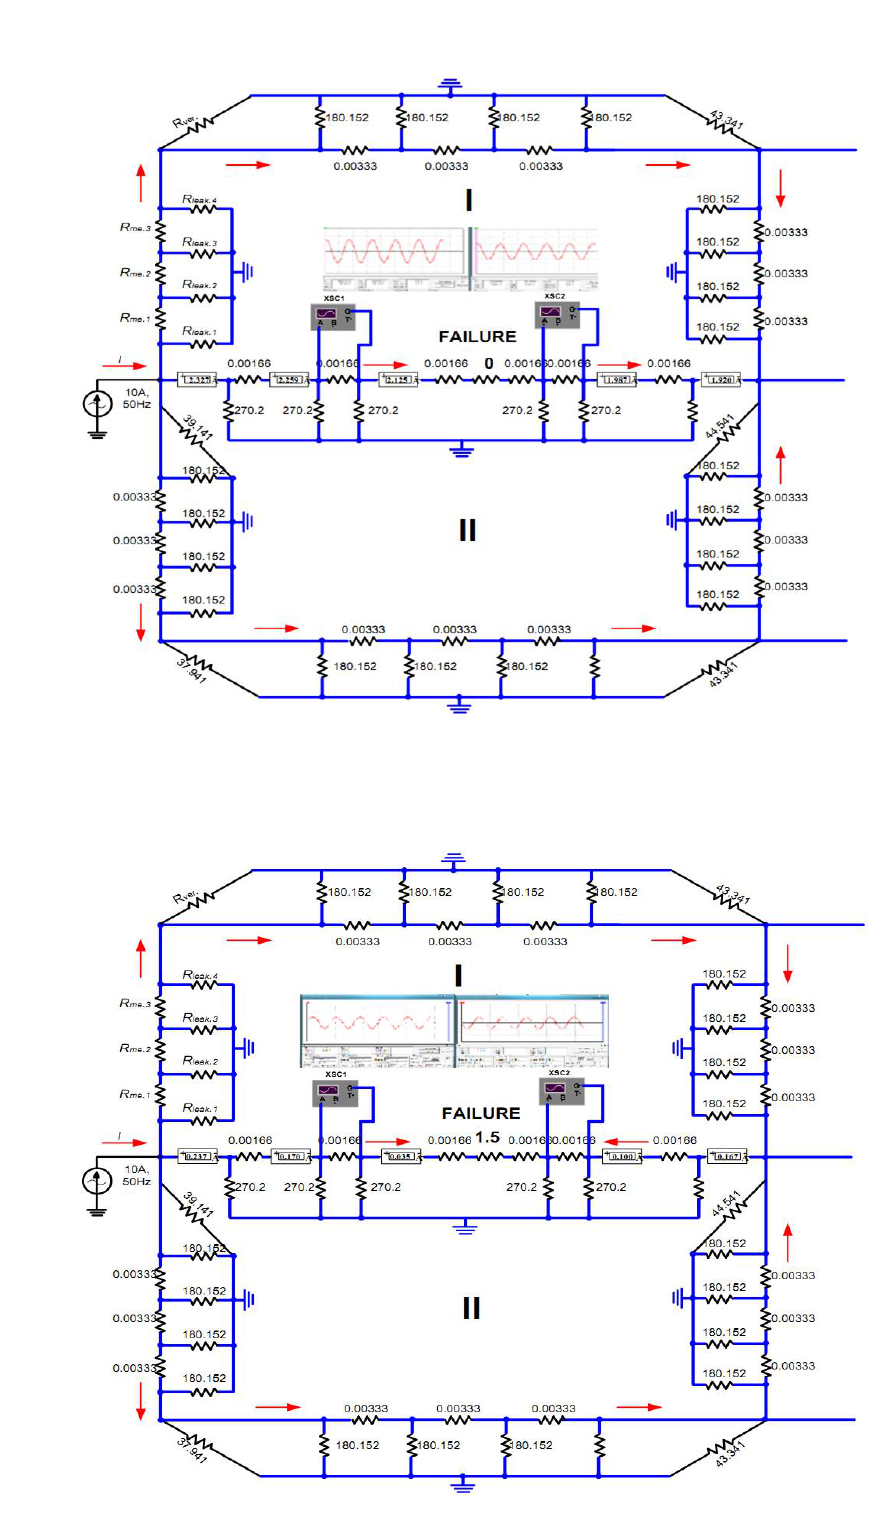
Figure 2. Simulation with Damaged Horizontal Element (a) R